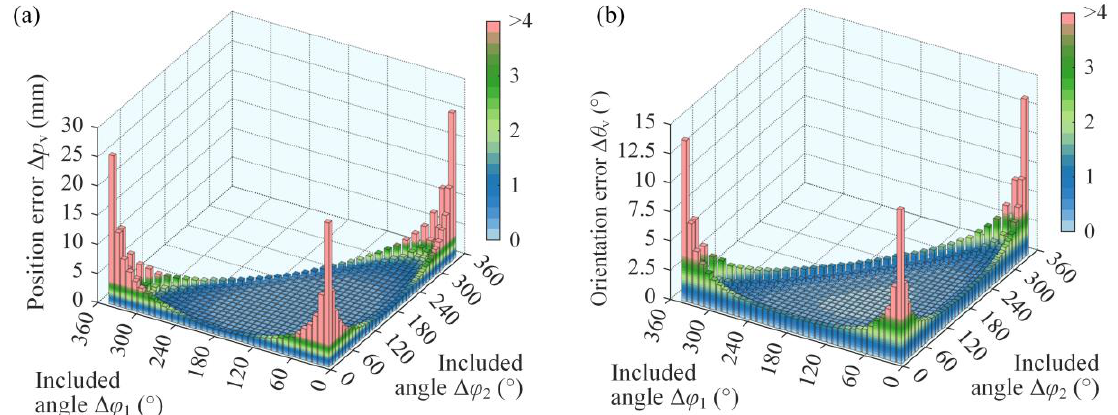
Figure 6. Recognition errors in ( a ) position and ( b ) orientation by using different combinations of included angles.